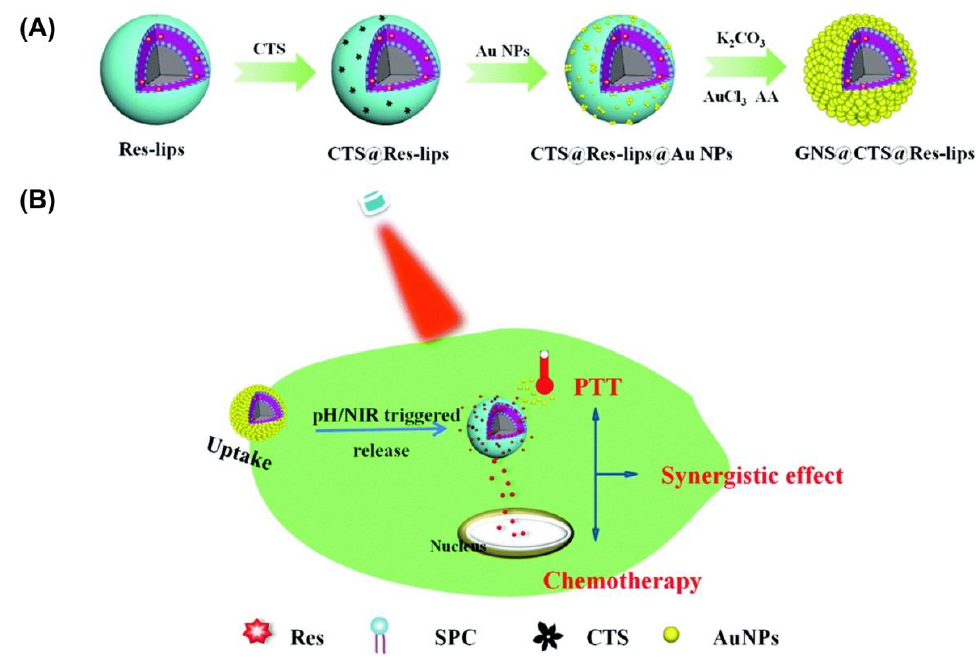
Figure 11. ( A ) Schematic representation of the synthetic strategy for GNS@CTS@Res-lips. ( B ) GNS@CTS@Res-lips as pH/NIR dual-responsive drug deliveries for synergistic chemo-photothermal cancer therapy. Reproduced from [170] with permission, copyright 2017, Royal Society of Chemistry.